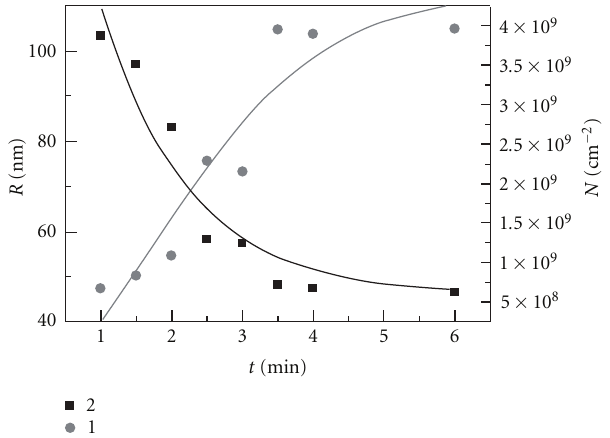
Figure 3: Time dependence of the middle radius R and concentra- tion N (1: crystal concentration N , 2: middle radius of crystals R